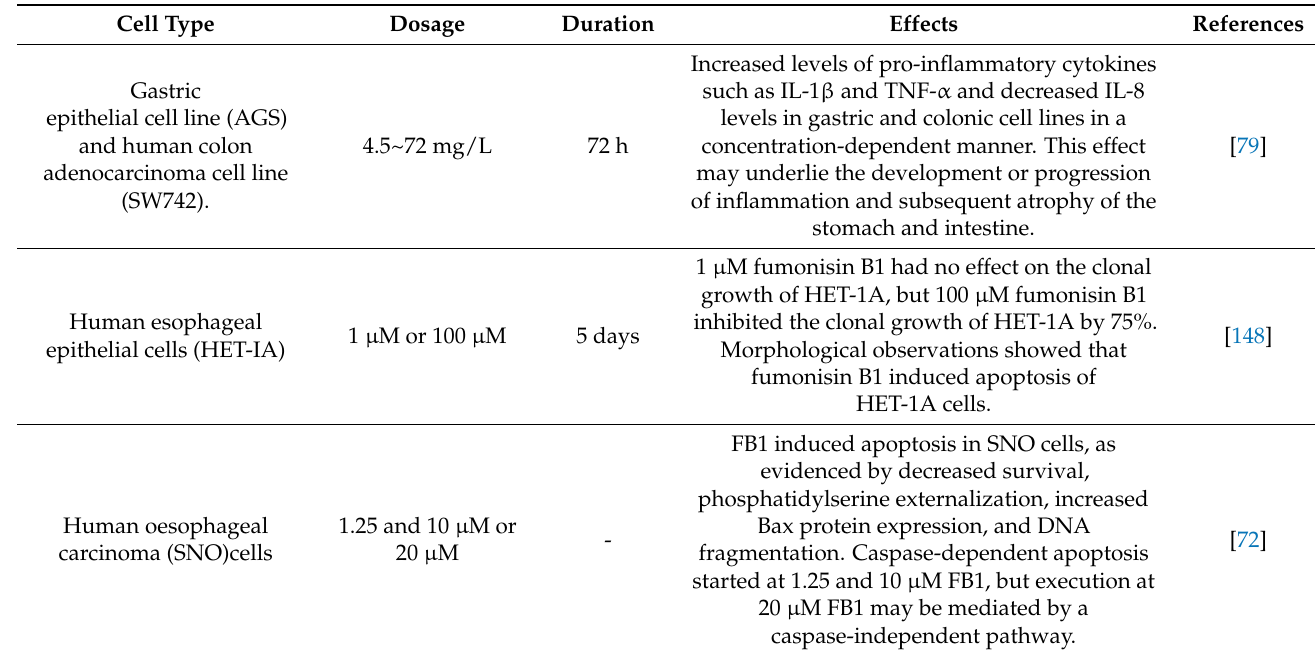
Table 5. Toxic effects of FB1 in human in vitro